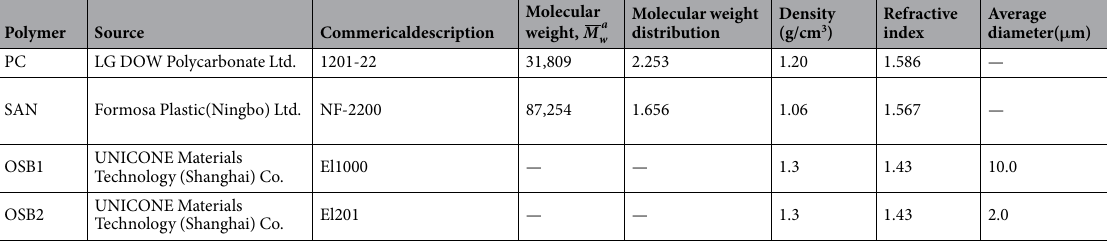
Table 1. Raw Materials Used in this Study ( a Determined here by